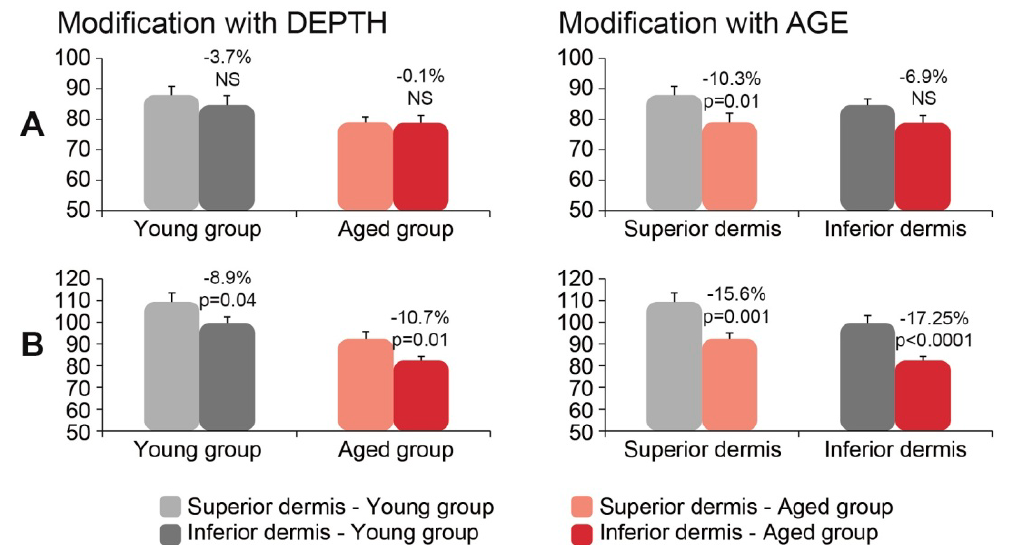
Figure 5. Collagen ( A ) and elastin intensity ( B ) modification with depth of dermis and age. Measurements were performed on the volar forearm. The results are shown as mean ± SEM ( n = 30) and p values are indicated for the significant